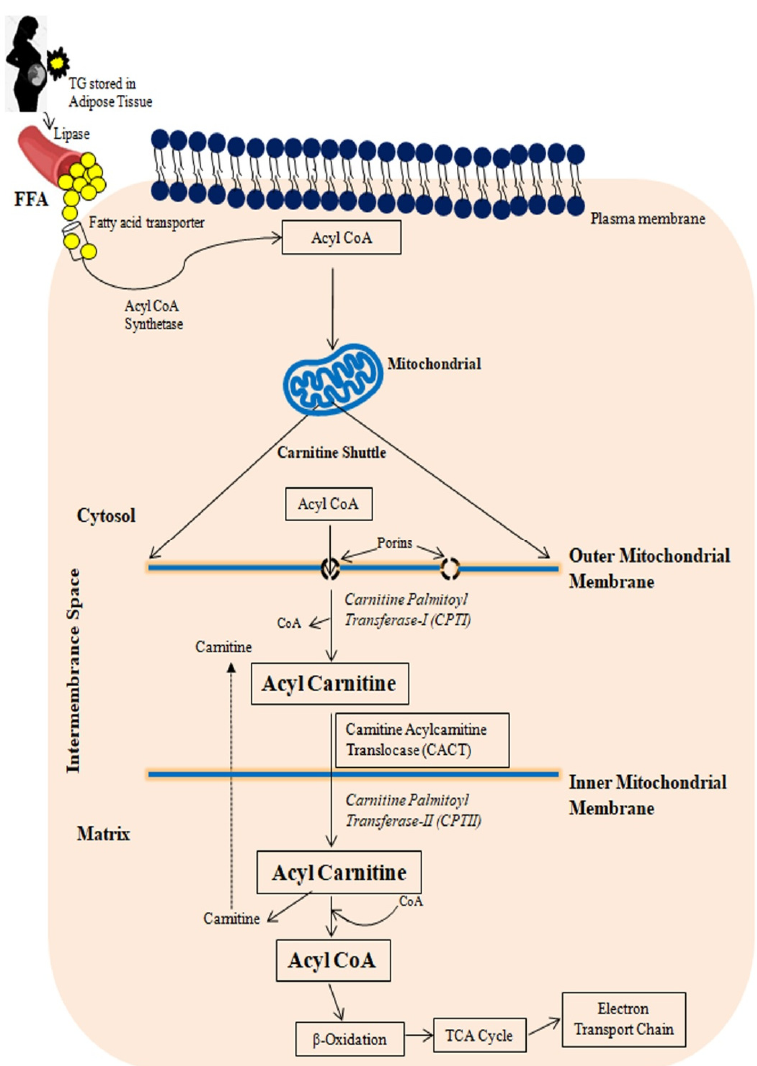
Figure 1. A schematic representation of free fatty acid transport to mitochondria. TG: Triglyceride; FFA: Free fatty